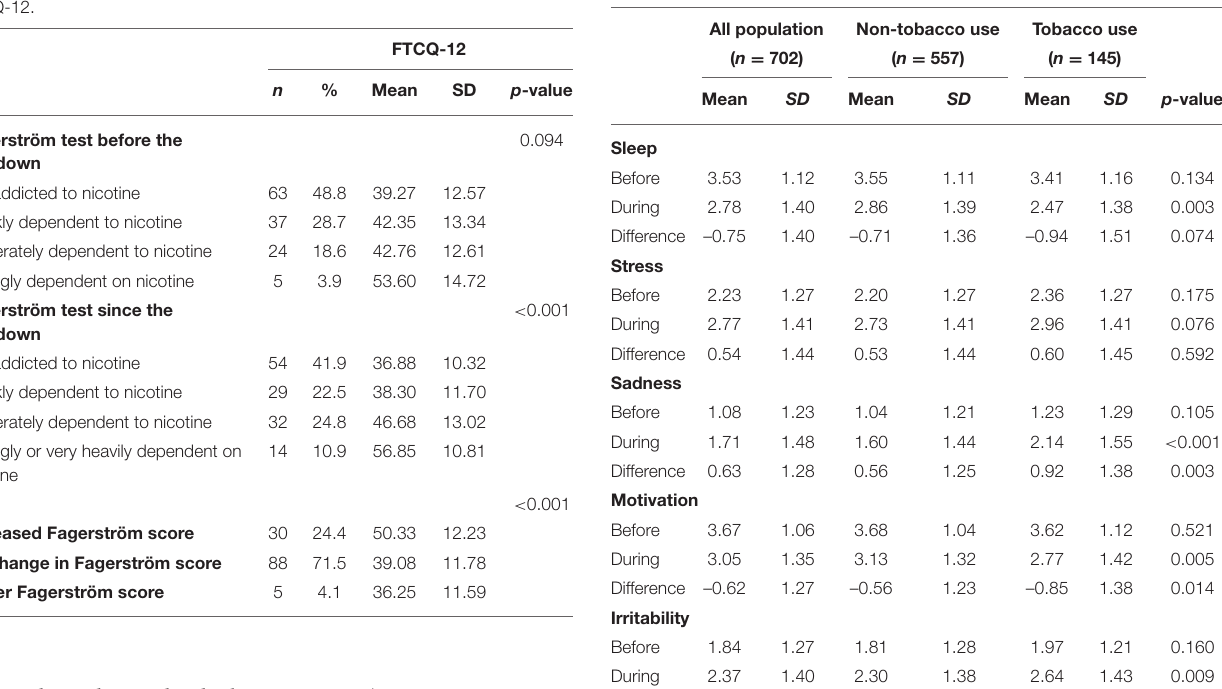
TABLE 3 | Impact of the lockdown on psychological distress values.